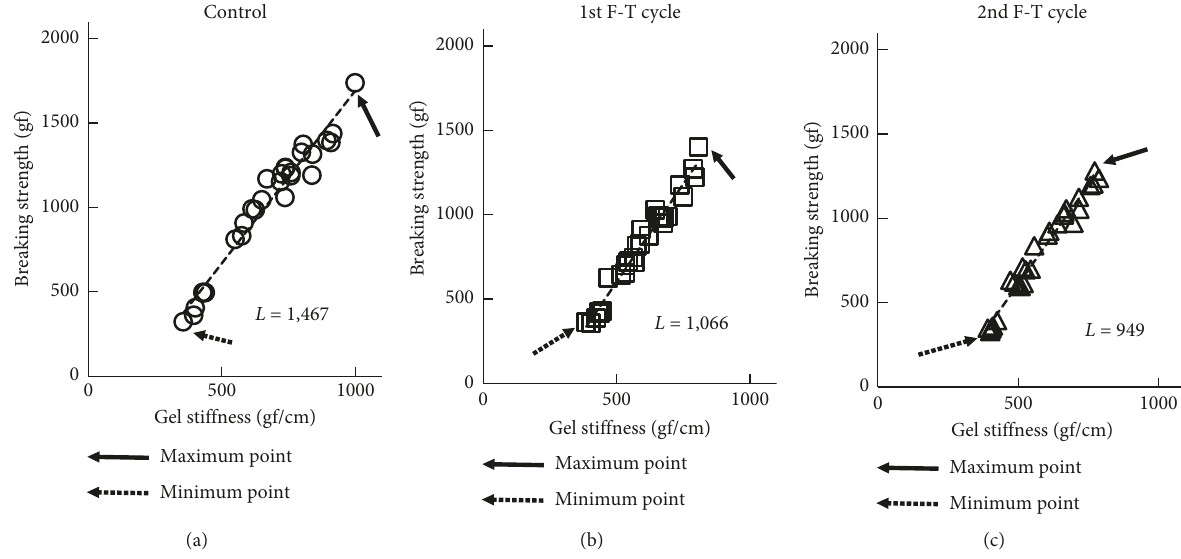
Figure 5: Relationship between breaking strength and gel stiffness of direct and/or two-step heated gel prepared from each frozen surimi sample. The L value indicates the approximate length of the straight line from the minimum point to the maximum point. Minimum point and maximum point are defined in Figure